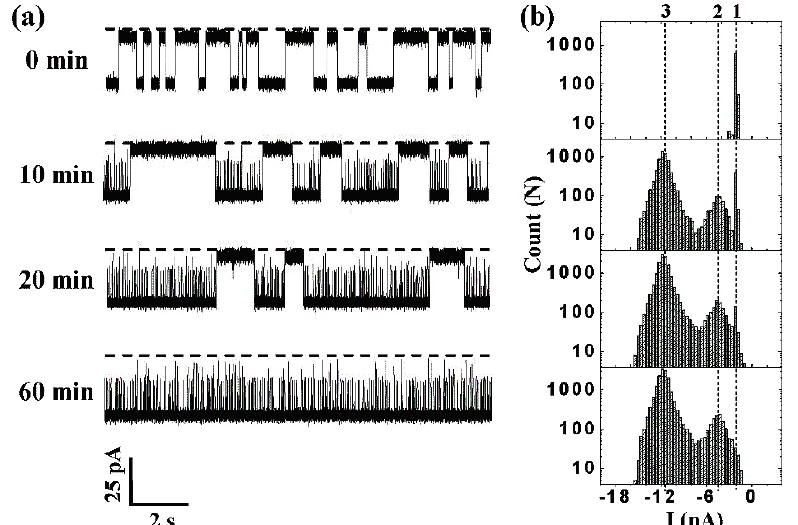
Figure 2. Detecting of A- β (10-20) cleavage by trypsin. ( a ) Single channel at different times of the recording track representative fragments. Dashed lines mean zero current; ( b ) Histograms of corresponding time-dependent event amplitude. The mean residual current levels of peptides YEVHHQKLVFF, YEVHHQK, and LVFF are represent by dashed lines 1, 2, and 3. Reproduced with permission from